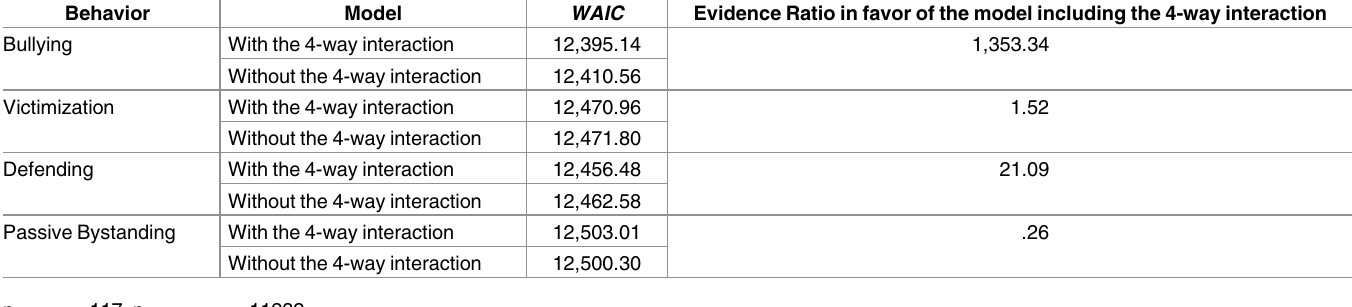
Table 6. Comparison of Bayesianlogistic mixed-effects models with emotion recognition as dependent variable by behavior during bullying episodes.